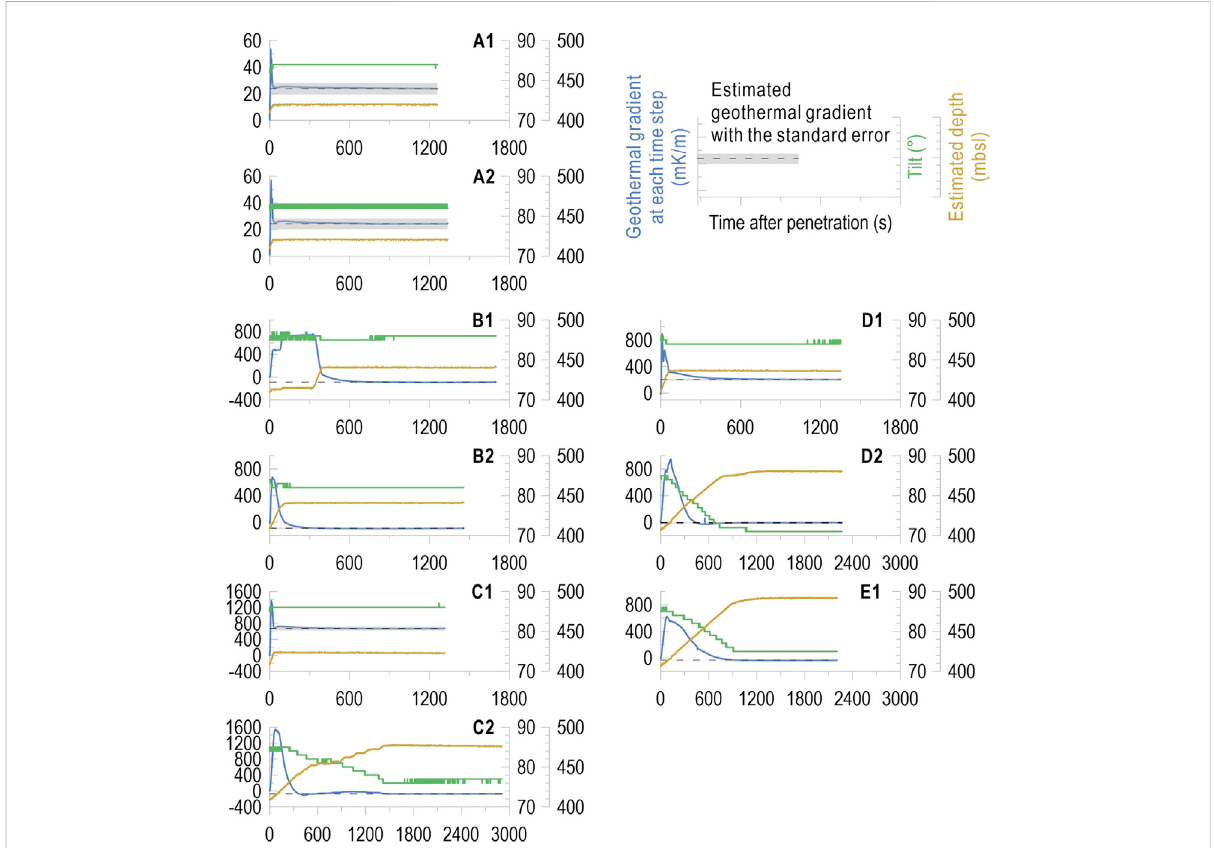
FIGURE 4 Geothermal gradient at each time step (blue line) from penetration to initiation of pulling out for Observations ( A1 – E1 ). It became convergent afteraninitiallargepeakforthe fi rst~5 min.Atthetimingjustbeforeinitiationofpullingout,thegeothermalgradient(dashedblackline)isestimated with the standard error (gray zone) using the “ direct manner ” (Pfender and Villinger, 2002). The tilt (green line) and depth (gold line) are also presented. After penetration, the tilt change is less than 10 °